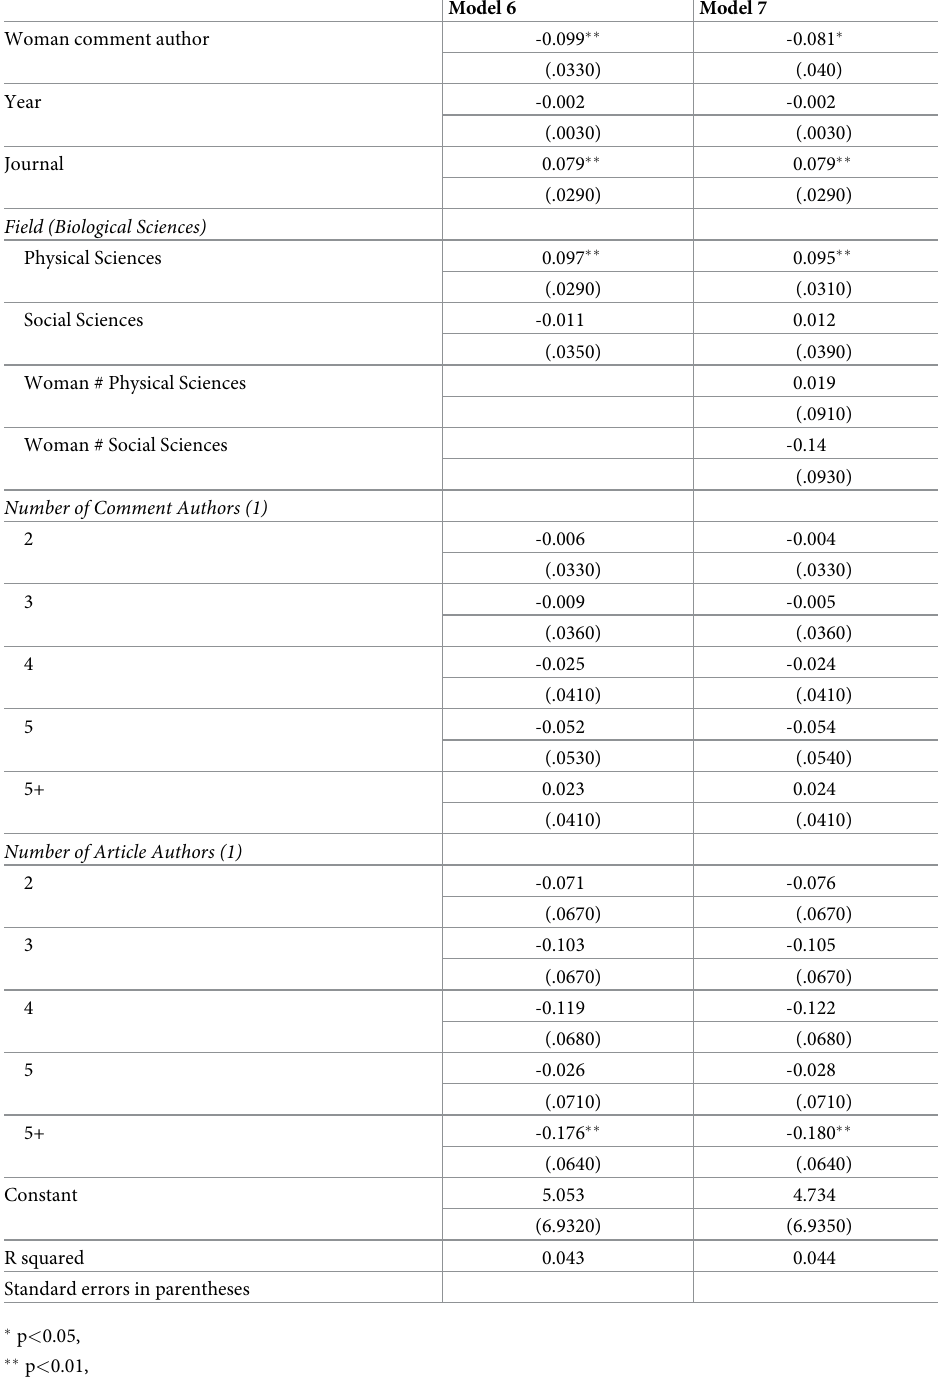
Table 3. Linear probability estimates that first author of targeted article is a